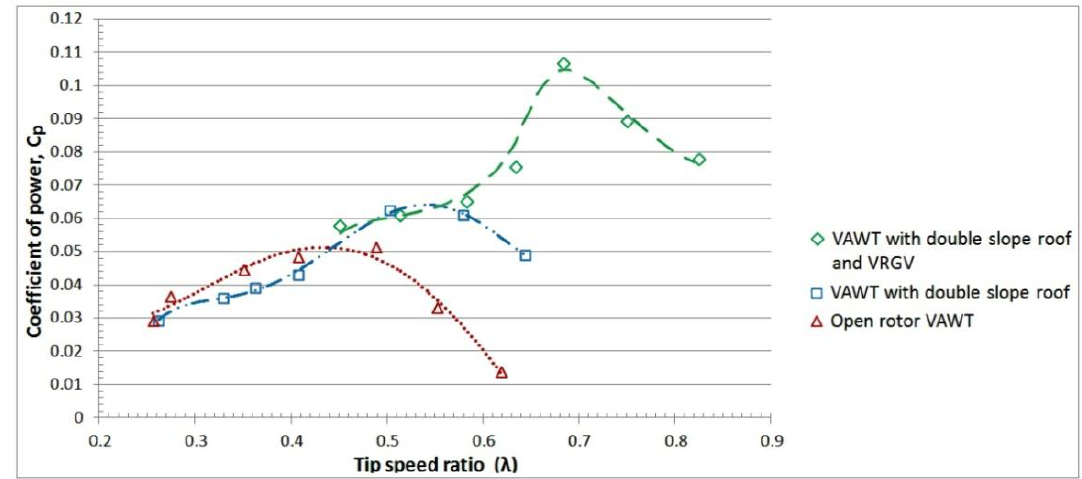
Figure 21. Coefficient of power, C p versus TSRs for an open rotor VAWT, VAWT with double slope roof, VAWT with double slope roof and VRGV.